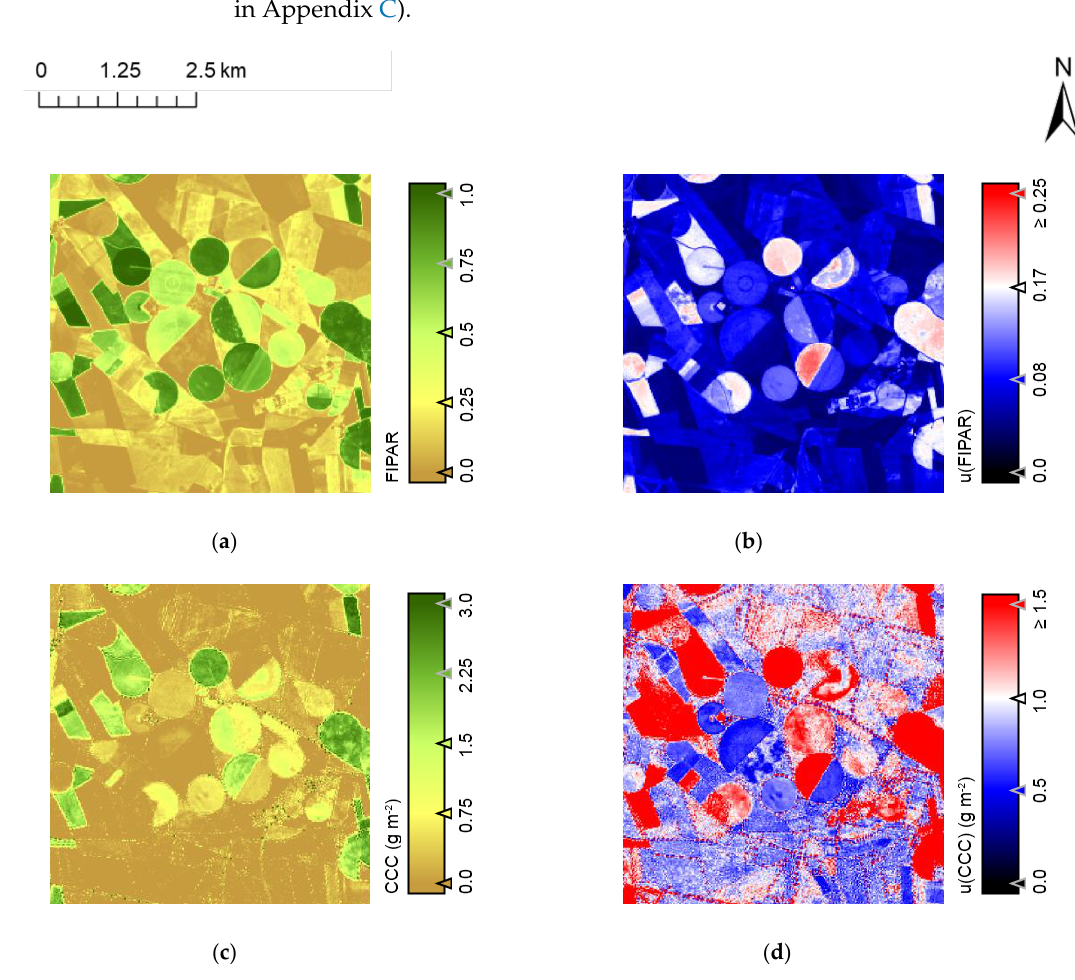
Figure 8. High-spatial-resolution maps (left) and per-pixel standard uncertainties (right) of FIPAR (a,b) and CCC (c,d) from the Las Tiesas–Barrax campaign.